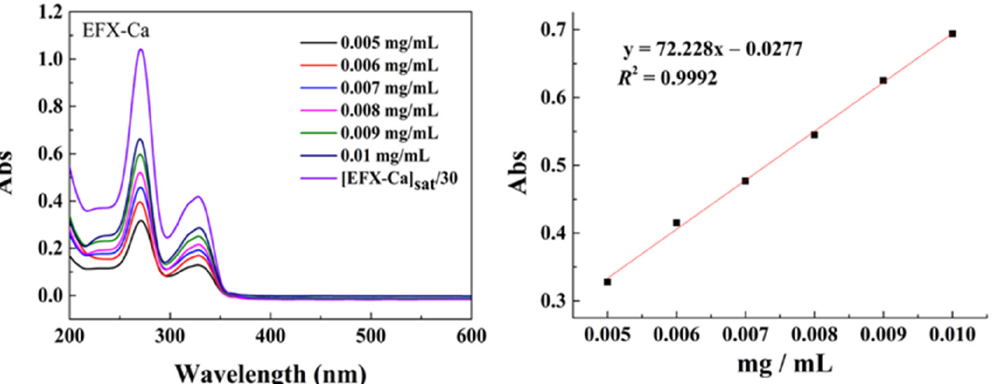
Figure 2. The water solubility of EFX-Ca at room temperature was determined by the Lambert–Beer law based on the standard line of the water solubility of EFX-Ca derived from a series of determined concentrations. The concentration of the working solution of EFX-Ca indicated by the UV-Vis spectrum was based on a 30 × dilution on the saturated aqueous solution of EFX-Ca.